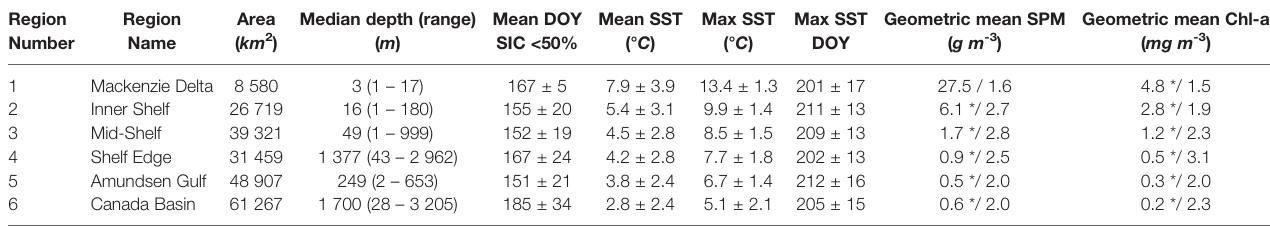
TABLE 1 | Descriptive statistics from 2003 – 2019 of the six SOM regions, including the area, median depth and depth range of each region. Region Region